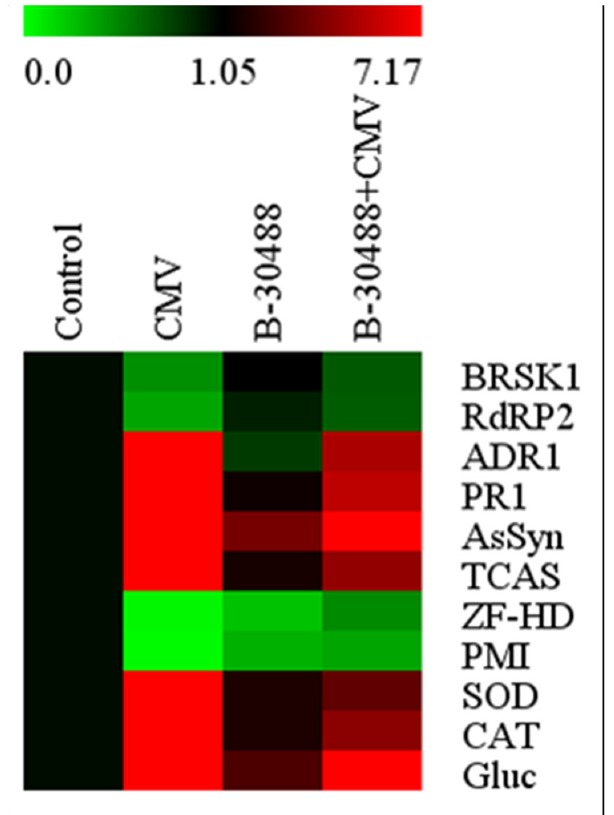
Fig 5. Quantitative validation of relative expression of selected transcripts related to development, stress and pathogenesis. Heat map of BR-SK1, RdRP2, ADR1, PR1, AsSyn, TCAS, ZF-HD, PMI, SOD, CAT and Gluc genes showing their relative expression by qRT-PCR. The signal intensity of each transcript was normalized using Actin (a house keeping gene). The top most bar represents the fold change expression values of selected